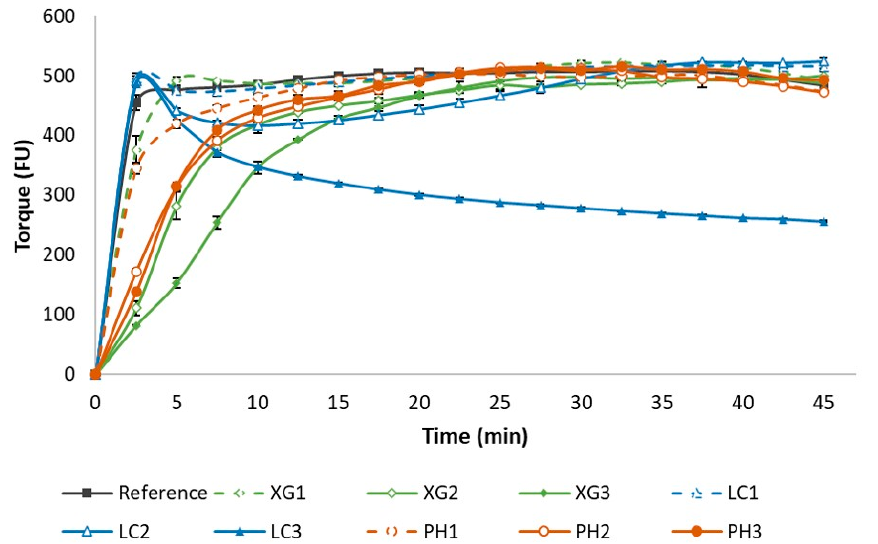
Figure 1. Farinographs show dough development of flour samples, the control and flour with xanthan (XG), lambda-carrageenan (LC) and psyllium husk (PH) addition at three concentrations of 1.0, 3.0 and 5.0% w / w based on flour weight (denoted as 1, 2 and 3, respectively) over a 45 min mixing regime. Error bar represents mean ± standard deviation, n = 3.